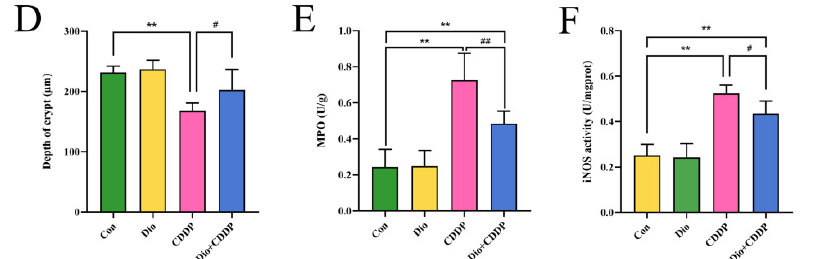
Figure 2. Ameliorative effect of Dio on ileum tissue injury and inflammatory cell infiltration in rats with CDDP-induced mucositis. ( A ) Intestinal tissues were stained with H and E dye kits (160 × , 450 × ). Note: Normal epithelial cells (Yellow arrows), apoptotic epithelial cells (Red arrows), normal crypt cells (blue arrows), and Black and blue arrows indicate ablated crypt cells and broken central lacteal duct in cisplatin rats, respectively. ( B ) Histological damage score. ( C ) villus length, ( D ) crypt depth. In addition, determination of MPO ( E ) and iNOS ( F ) activity to determine inflammatory infiltration. All values were expressed as Mean ± S.D. (n = 6 samples per group). ** p < 0.01 vs. control group, # p < 0.05, ## p < 0.01 vs. CDDP group.